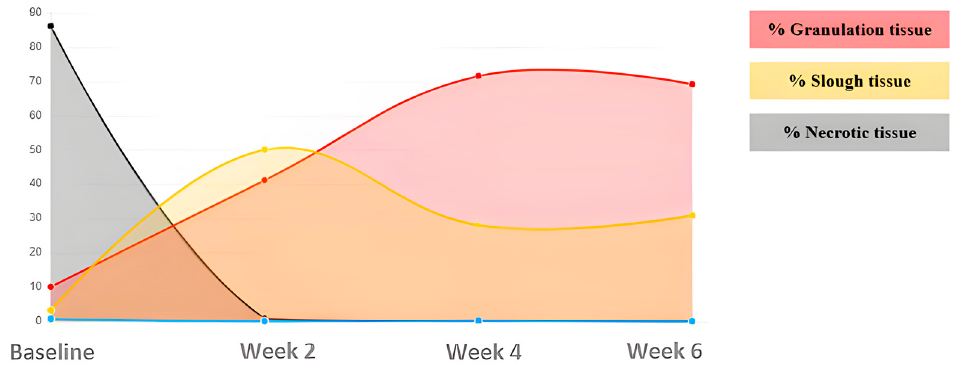
Figure 3. Healing evolution case 2: Baseline assessment ( left ), Baseline HELCOS analysis ( centre ), Week 8 assessment ( right ).